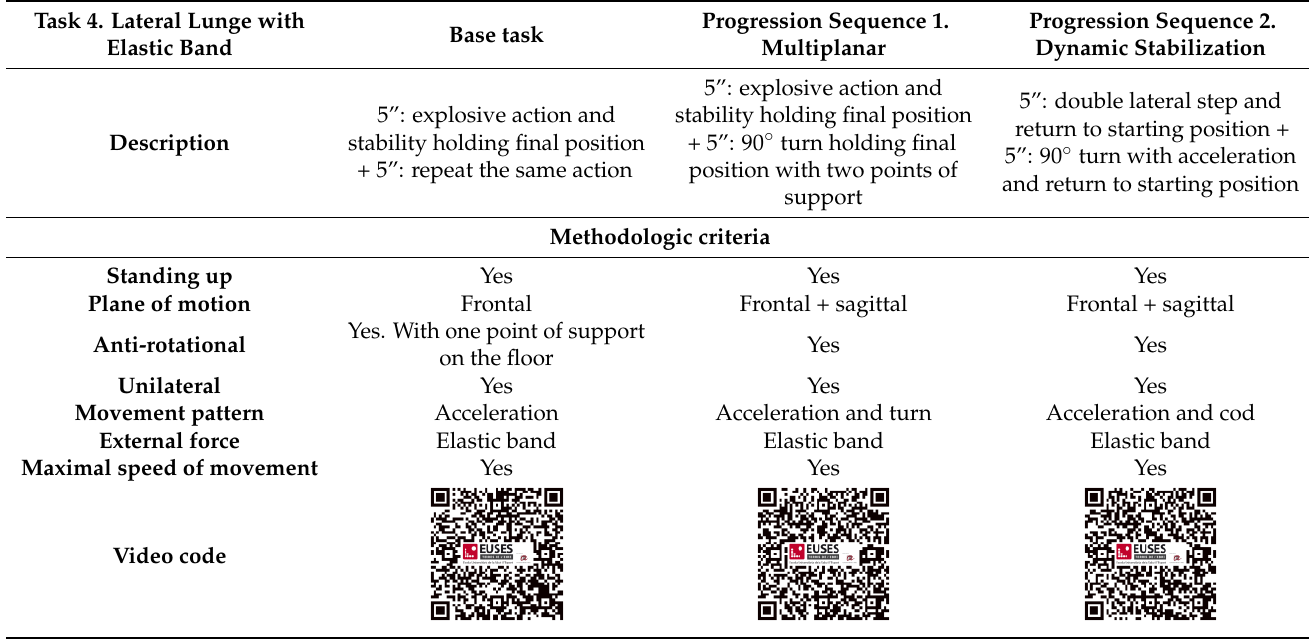
Table 4. Description and methodologic criteria of SCS group’s task 4 and its progressions.